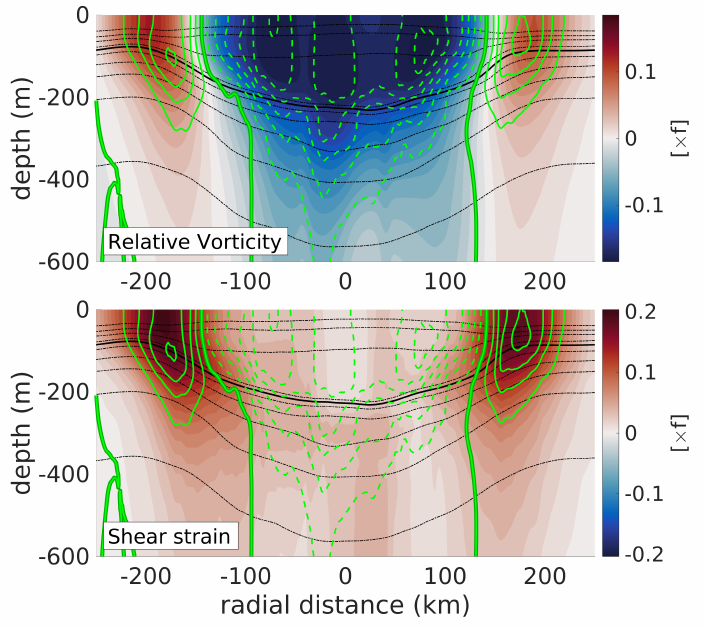
Figure 11. Top panel: Vertical section of relative vorticity non-dimensionalized by the Coriolis frequency f computed using the corrected horizontal coordinate. The Okubo–Weiss parameter (OW) is shown as green contours. The dashed contours represent negative OW, while the continuous contours represent positive values. The thick line is the zero-OW contour. Bottom panel: Same as top panel for the shear strain.